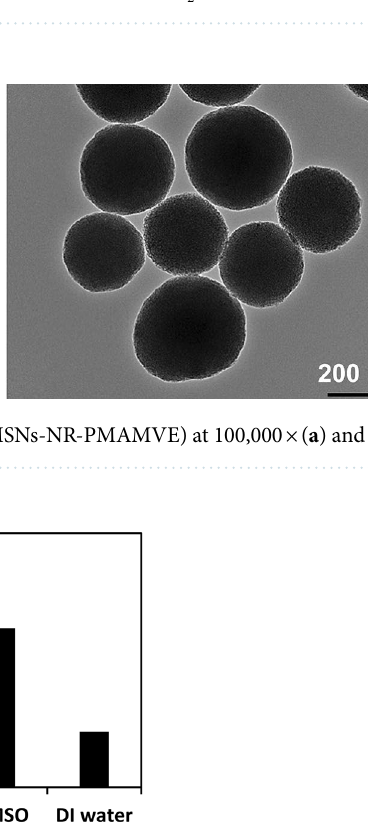
Table 1. The result of dynamic light scattering measurement of NH 2 -MSNs-NR-PMAMVE.